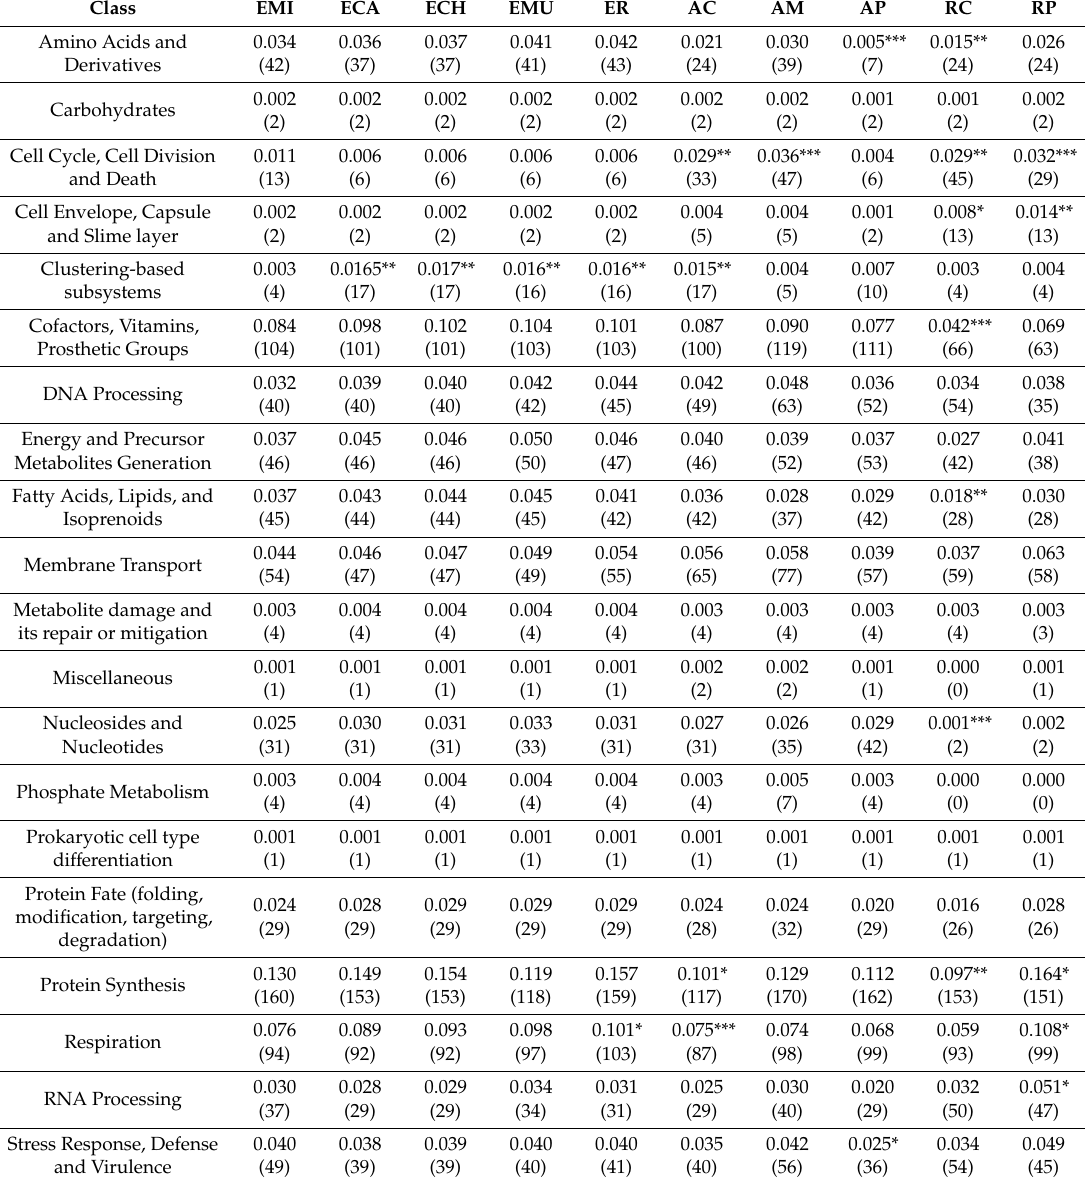
Table 2. Comparison of genome functional